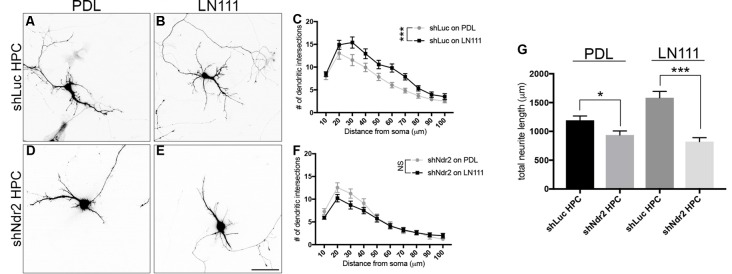
Ndr2 kinase is required for LN111 enhancement of dendritic growth in hippocampal neurons. Primary hippocampal neurons transfected with shLuc plasmid and plated on (A) PDL and (B) LN111. (C) Sholl analysis of their dendrites reveals that LN111 substrates increase the dendrite branching significantly compared to PDL coating (two-way ANOVA between substrates: F(1,54)= 12.16, p = 0.0010, n = 26 for PDL and 30 for LN111). (D–F) On the other hand, when Ndr2 kinase is silenced, dendritic morphology of the neurons are unchanged between substrates (two-way ANOVA between substrates: F(1,58) = 1.262, p = 0.2660, n = 30 for PDL and 31 for LN111). (G) In fact, silencing of Ndr2 kinase expression results in shorter total dendrite length compared to control neurons on both PDL and LN111 substrates (one-way ANOVA: F(3,113)= 17.33, p < 0.0001). Values are mean + SEM; *p < 0.05; ***p < 0.001.